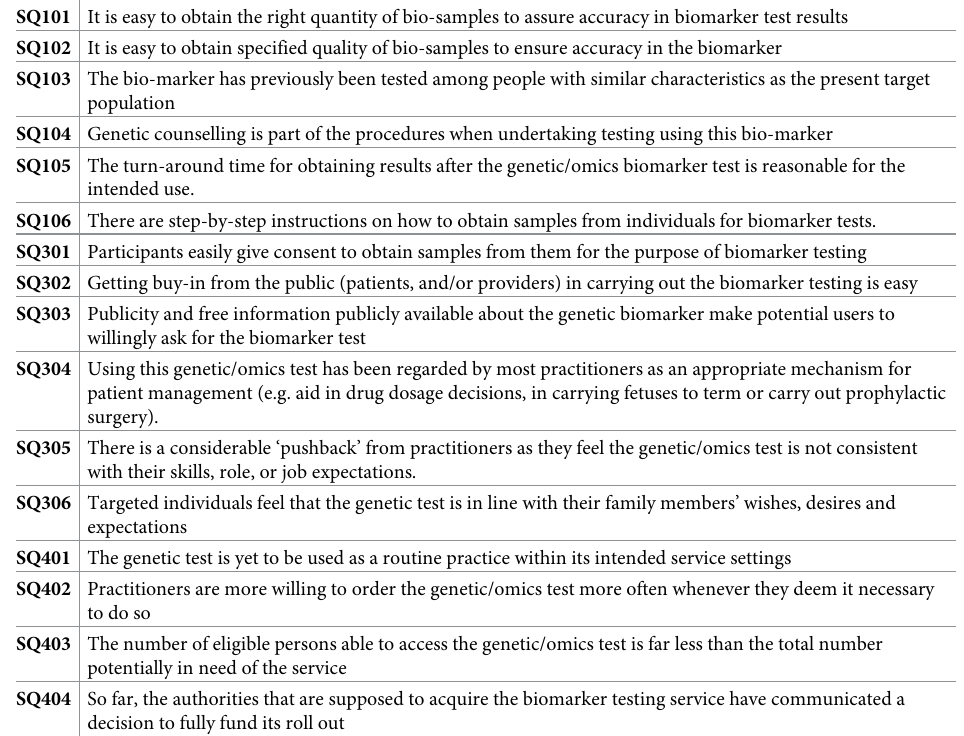
Table 1. Latent variable